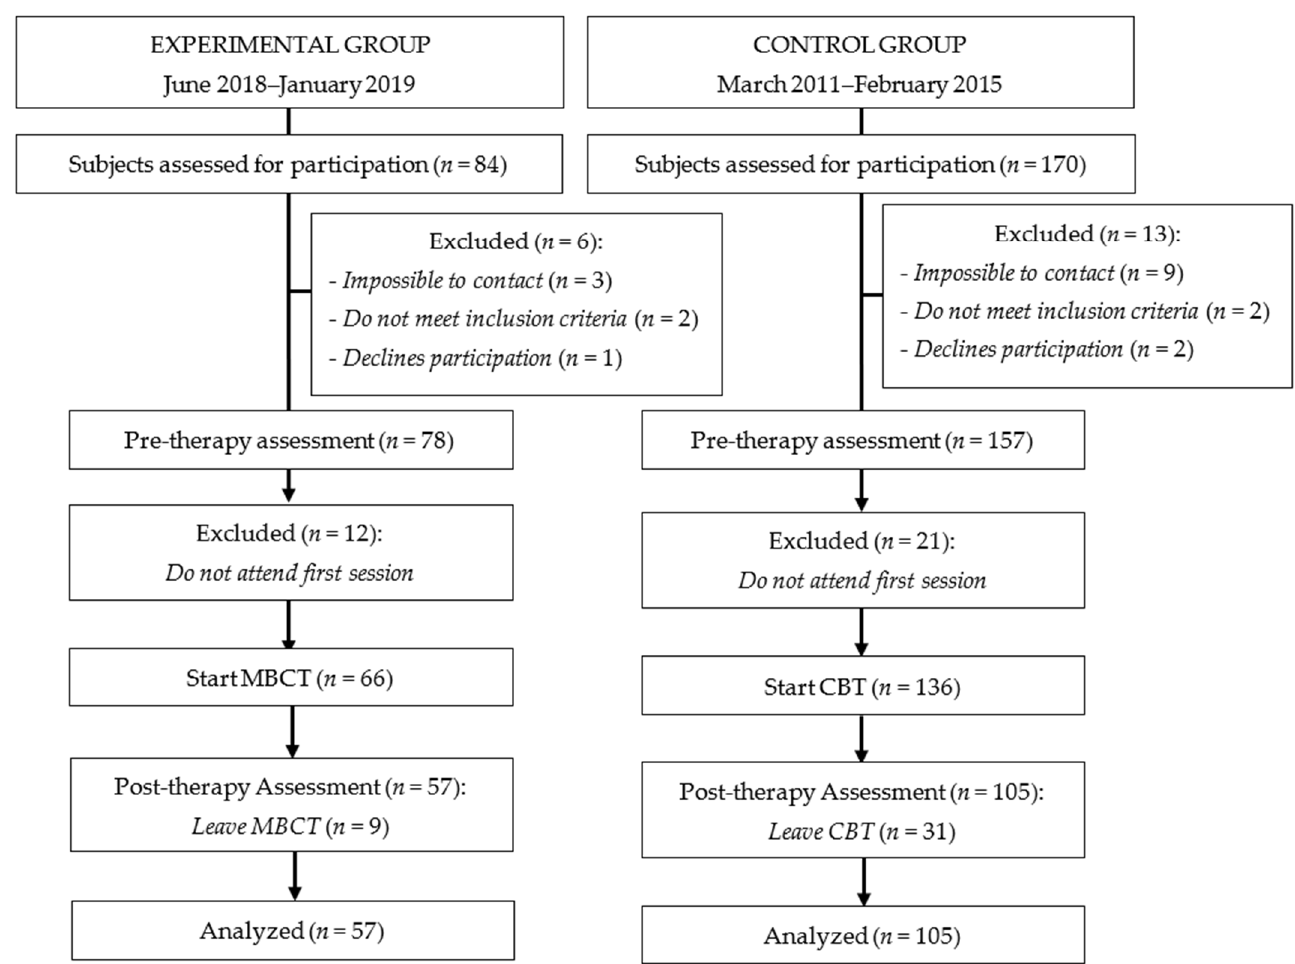
Figure 1. Flow diagram of participants.